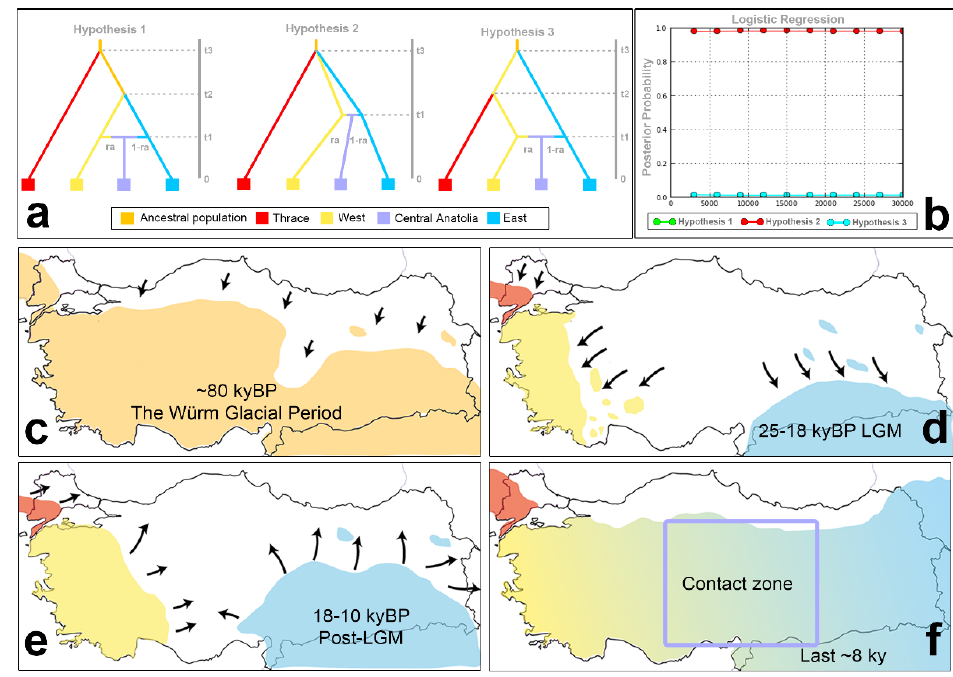
Figure 3. The ABC analysis results. ( a ) The comparison of the three hypotheses using the DIYABC approach for the four clusters of A. chukar identified in the cluster analyses in Figures 4 and 5. These clusters are Thrace: population 1, West: populations: 2, 3, 4, and 5, East: populations: 9, 10, 11, 12, 13, and 14, and Central Anatolia: populations: 6, 7, 8, 15, and 16. In these hypotheses, t: time in generations, N: effective population sizes of the different populations denoted by different colors, and r: immigration rates originating from the donor population. ( b ) The logistic regression plot for each simulated hypothesis, plotting the posterior probabilities (y-axis) by the number of simulations used to calculate it (x-axis). ( c – f ) The scenarios supported by the ABC analysis.